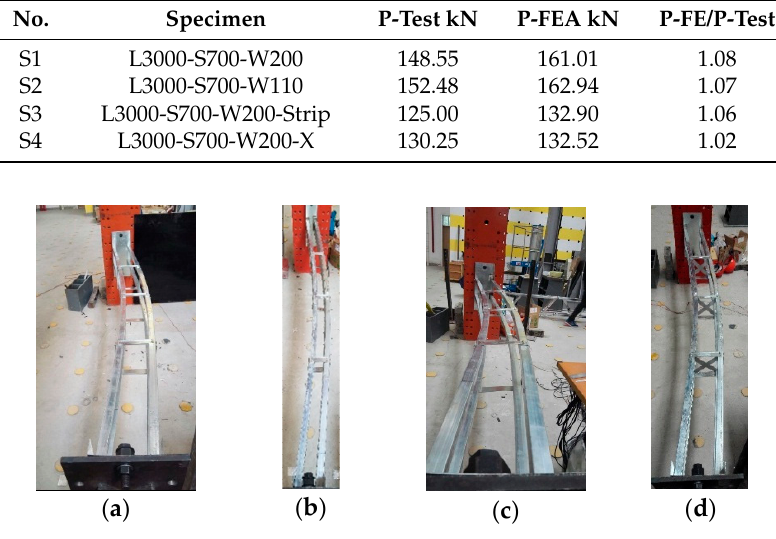
Figure 5. Deformed shapes at failure : ( a ) S1; ( b ) S2; ( c ) S3; ( d ) S4.